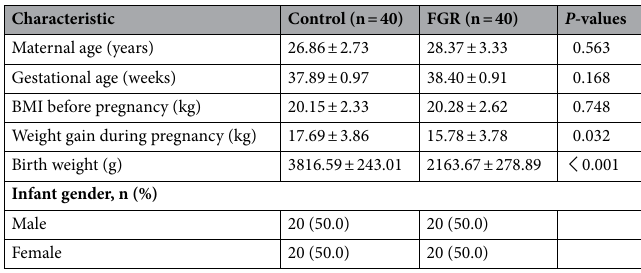
Table 2. Clinical characteristics of the study population. Values are mean ± SD.